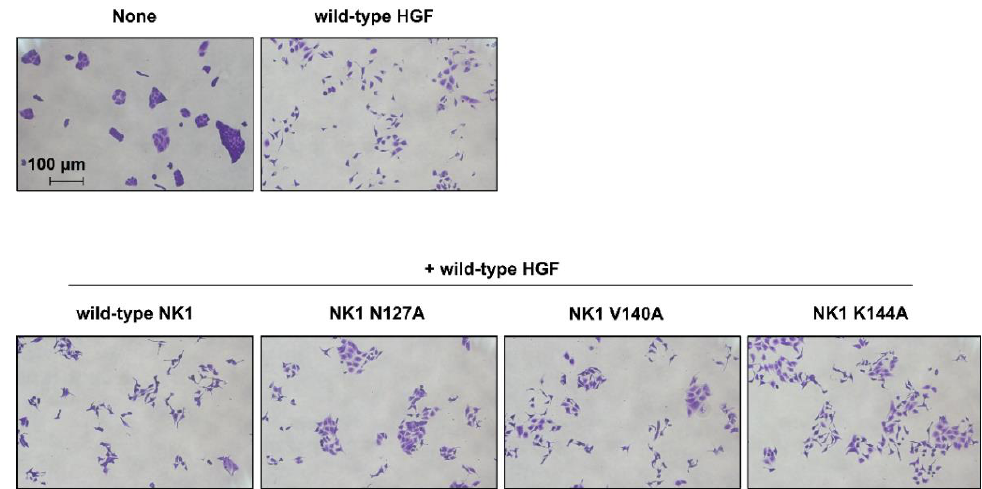
Figure 7. Effects of wild-type and mutant NK1 on HGF-induced cell scattering. MDCK cells were cultured with or without 0.1 nM HGF in the absence or presence of 250 nM wild-type or mutant NK1 for 20 h. The experiment was independently repeated twice, and similar results were obtained.